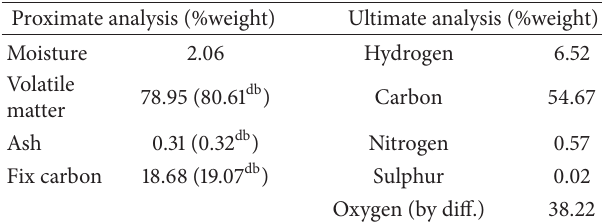
Table 2: Proximate and ultimate analysis of coconut shell